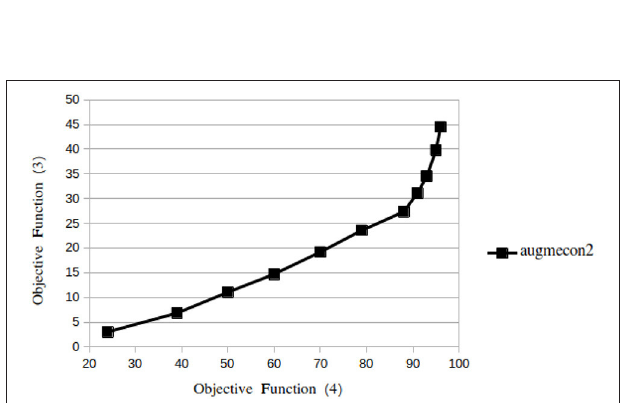
FIGURE 10 | The Pareto